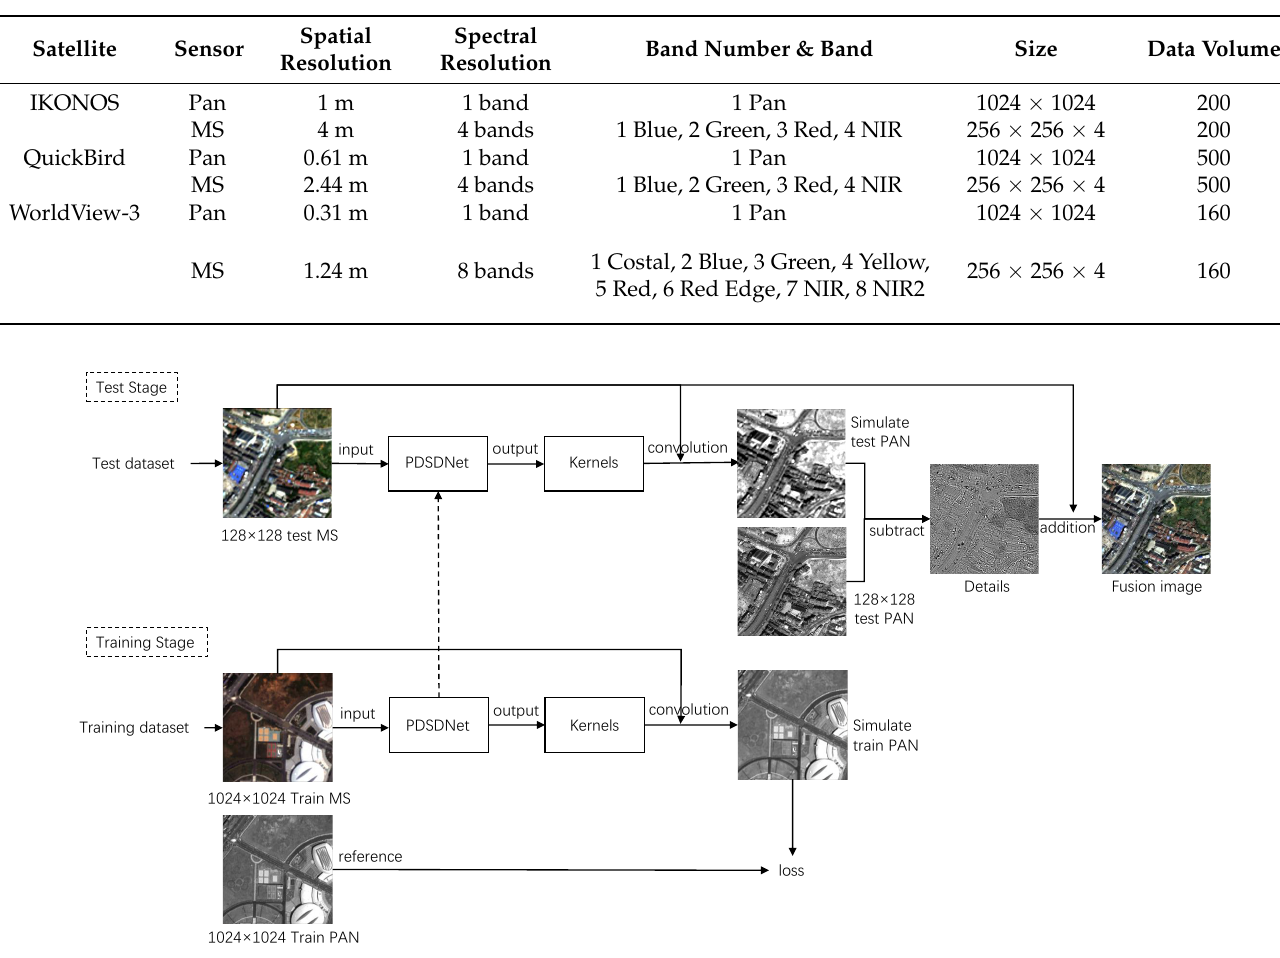
Figure 3. The process of our fusion